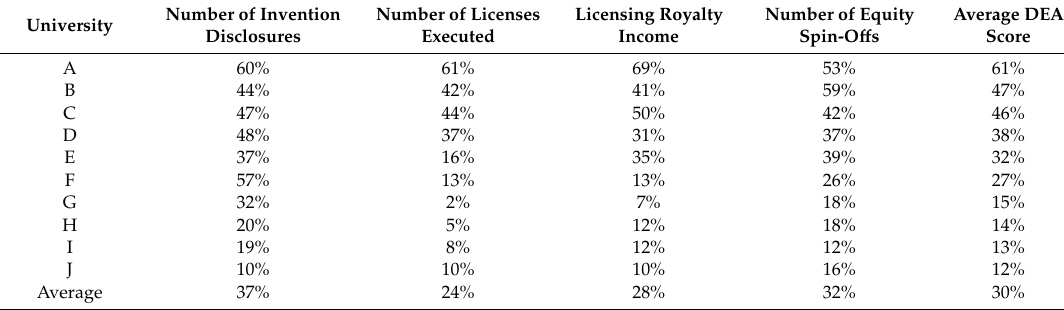
Table 2. Data envelopment analysis of university technology transfer performance measures.